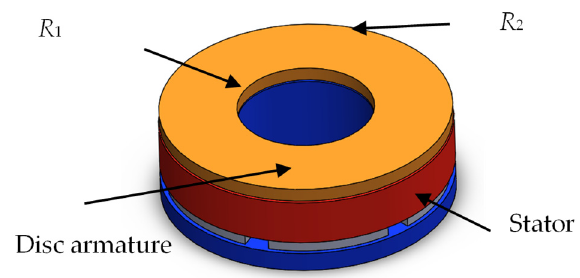
Figure 5. Radius of